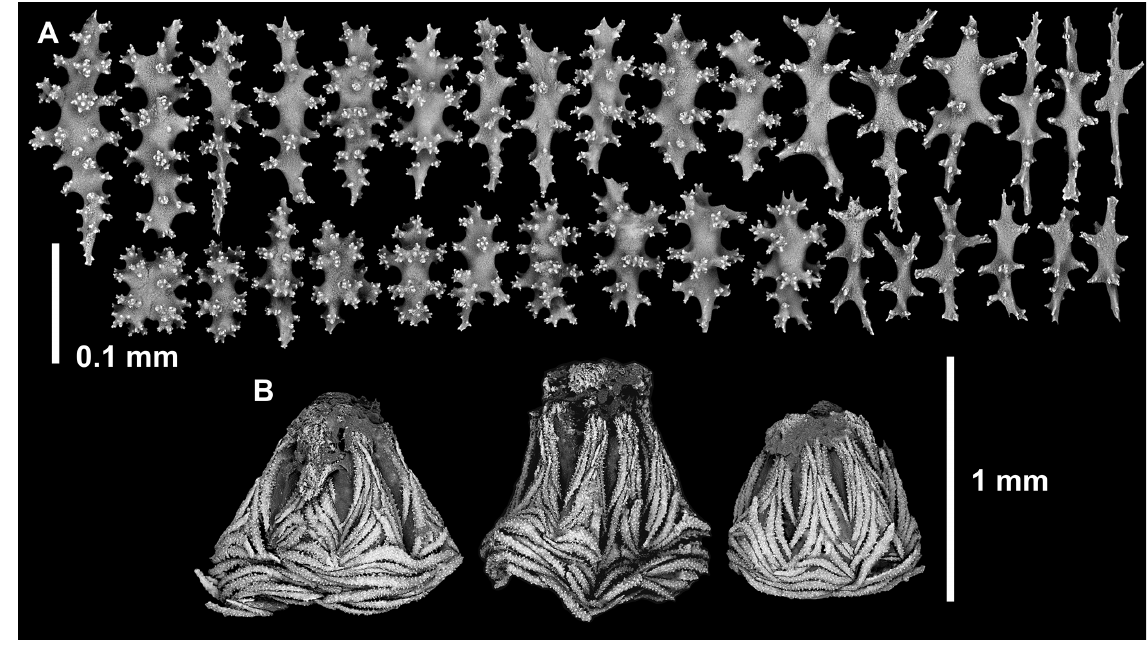
Fig. 10. Kotatea aurantiaca gen. et comb. nov. (NIWA 54766), SEMs of sclerites. A . Base interior. B . Polyps (in